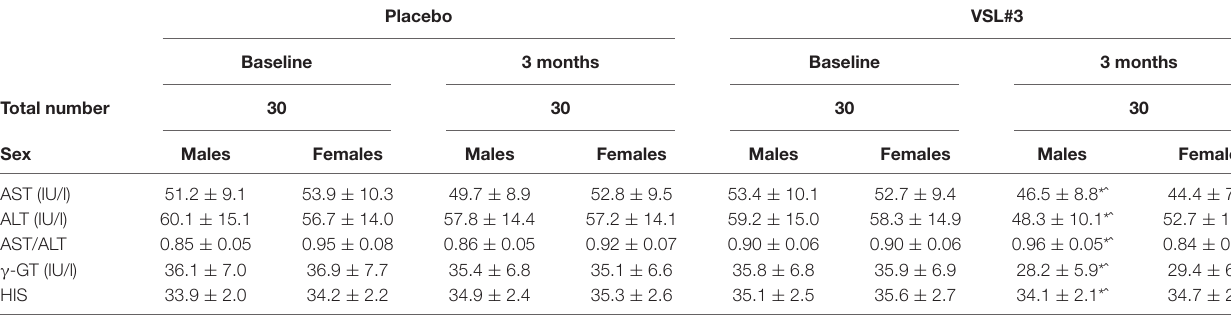
TABLE 2 | Hepatic values during VSL#3 R (cid:13) treatment at baseline and after 3 months.